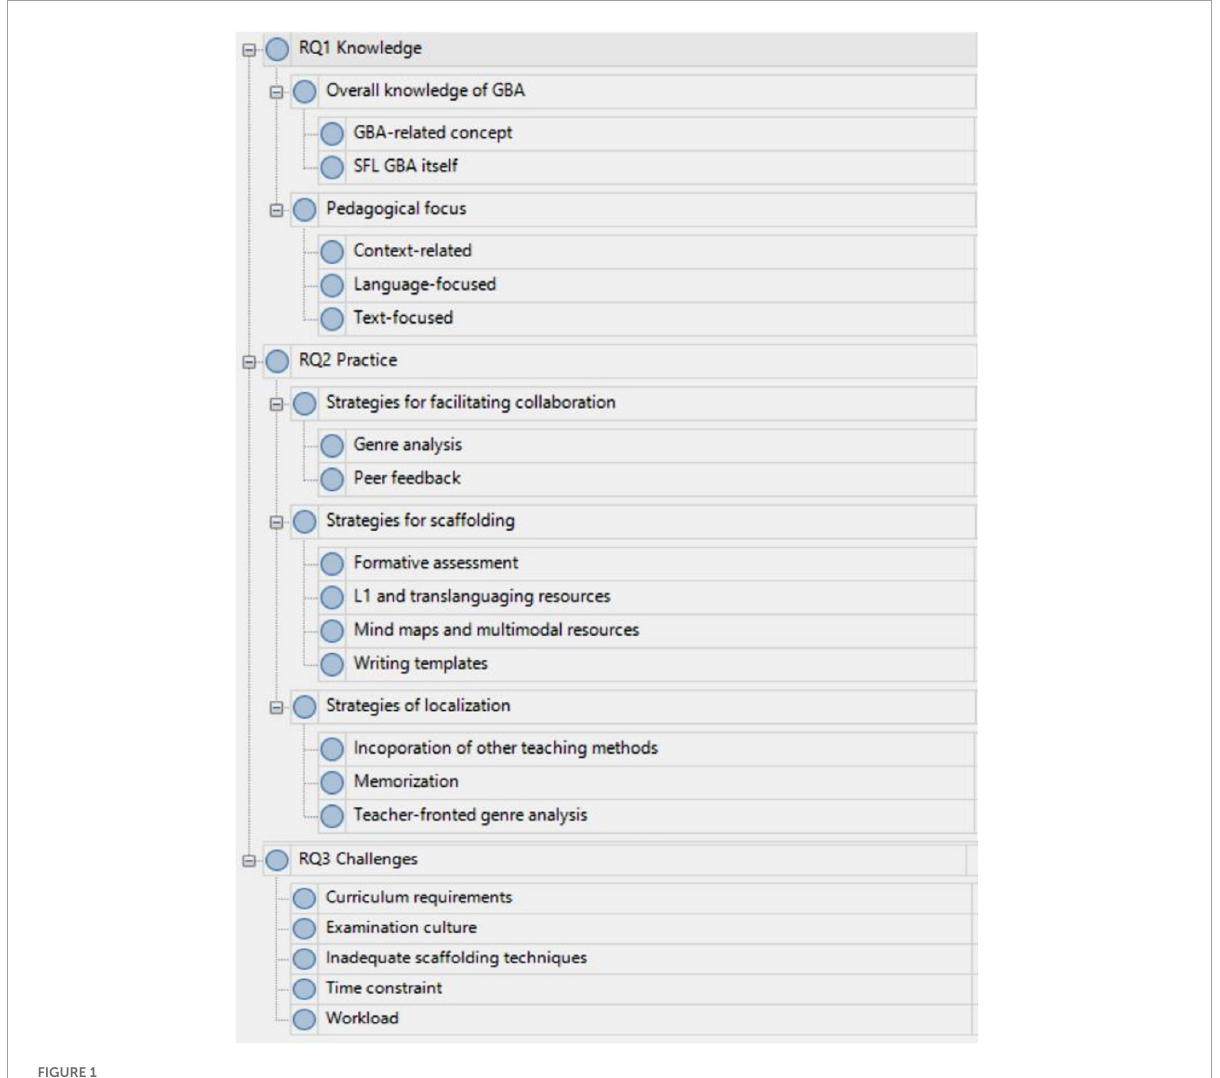
FIGURE1 A screenshot of the coding system in Nvivo. Reproduced with